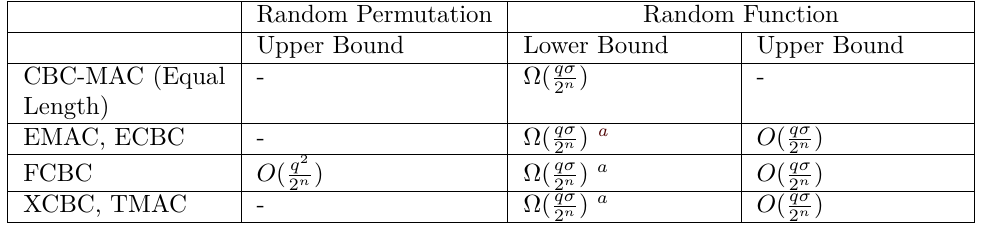
Table 2: New security bounds for CBC-MACs proved in this